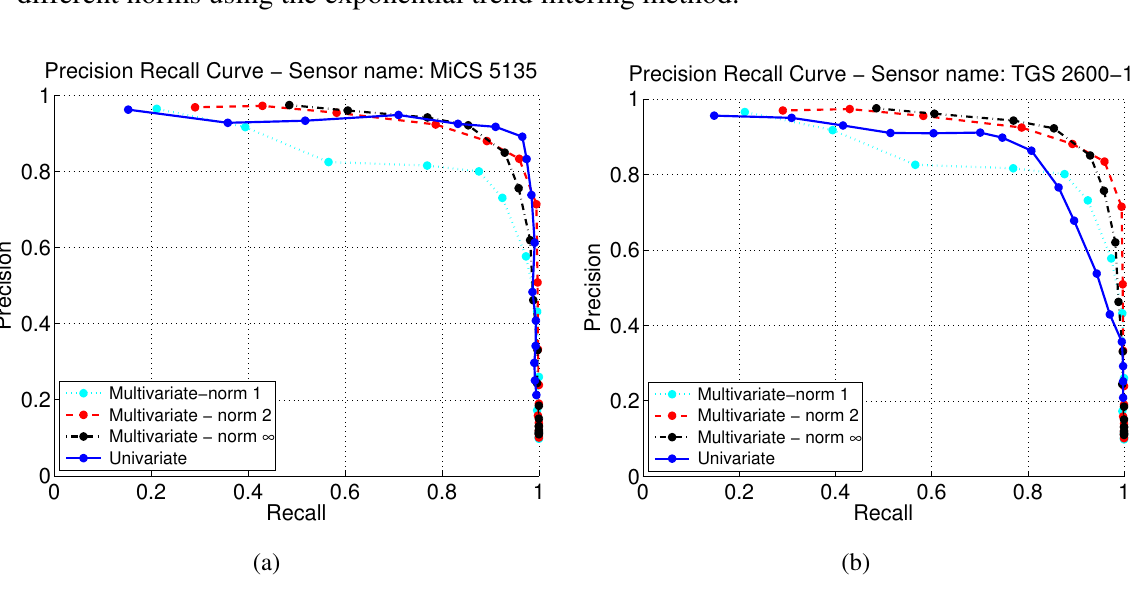
Figure 9. Comparison of precision-recall curves of a single sensor and the sensor array with different norms using the exponential trend filtering